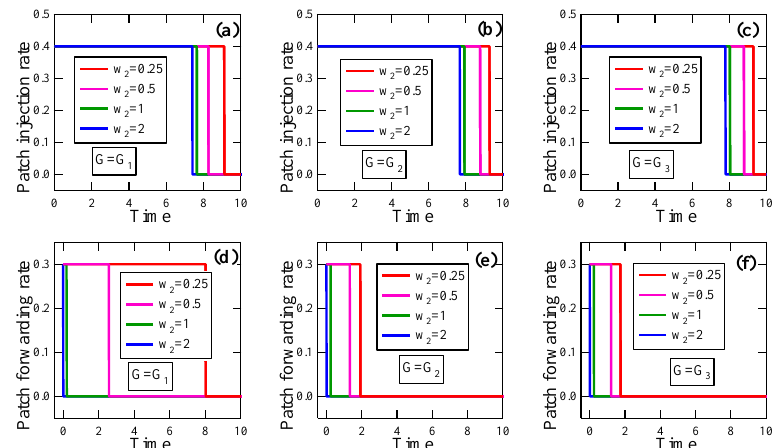
Figure 11. The experimental results in Experiment 1 about the effect of the energy coefficient on the optimal patching strategy. ( a ) Patch injection rate, G = G 1 ; ( b ) Patch injection rate, G = G 2 ; ( c ) Patch injection rate, G = G 3 ; ( d ) Patch forwarding rate, G = G 1 ; ( e ) Patch forwarding rate, G = G 2 ; ( f ) Patch forwarding rate, G = G 3